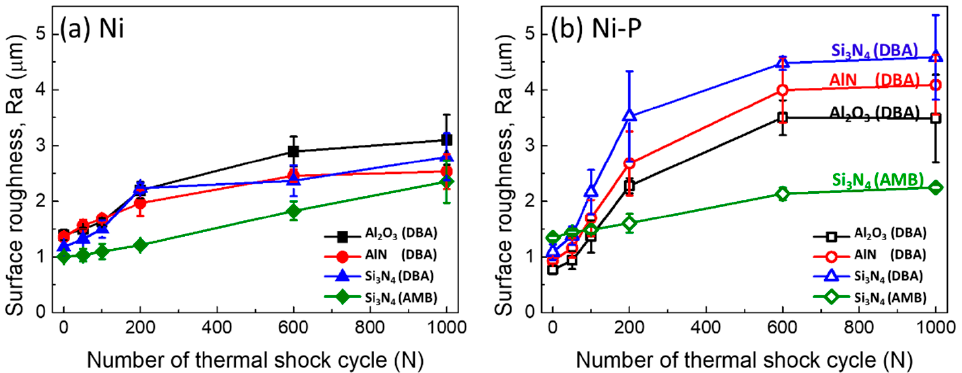
Figure 10. Variation in surface roughness of Ni ( a ) and Ni–P ( b ) layers on DBA/AMB substrates with Al 2 O 3 , AlN, and Si 3 N 4 up to 1000 cycles.